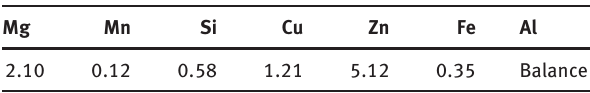
Table 1: Chemical composition (wt.%) of AA7075-T651 aluminium alloy.